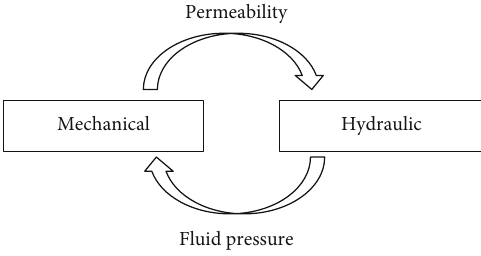
Figure 6: Couplings between mechanical and hydraulic processes.